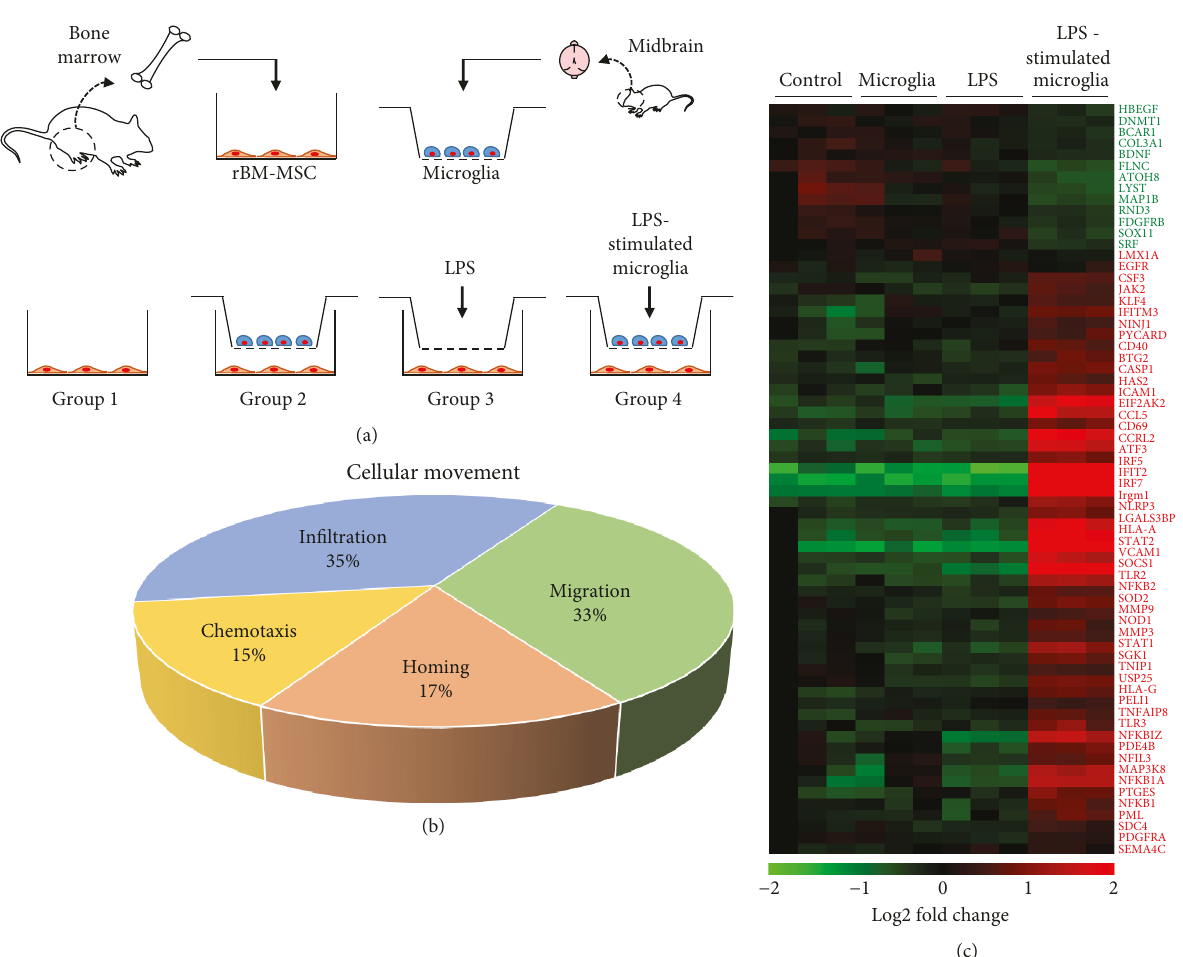
Figure 1: Cellular movement-related gene expression variation in rat bone marrow-derived mesenchymal stem cells (rBM-MSCs) cocultured with LPS-stimulated microglia. (a) In vitro coculture experimental design. Four di ff erent conditions were used (groups 1 – 4): group 1, rBM- MSCs only (control); group 2, rBM-MSCs cocultured with microglia; group 3, LPS-treated rBM-MSCs; and group 4, rBM-MSCs cocultured with LPS-stimulated microglia. (b) Gene categorisation according to subgroups related to cellular movement. Genes involved with cellular movement were categorised in subgroups (chemotaxis, homing, migration, and in fi ltration) based on microarrays and Ingenuity Pathway Analysis. (c) Heat map of genes related to cell migration in the 4 di ff erent groups with altered expression levels. Gene expression values are coloured from green (downregulated) to red